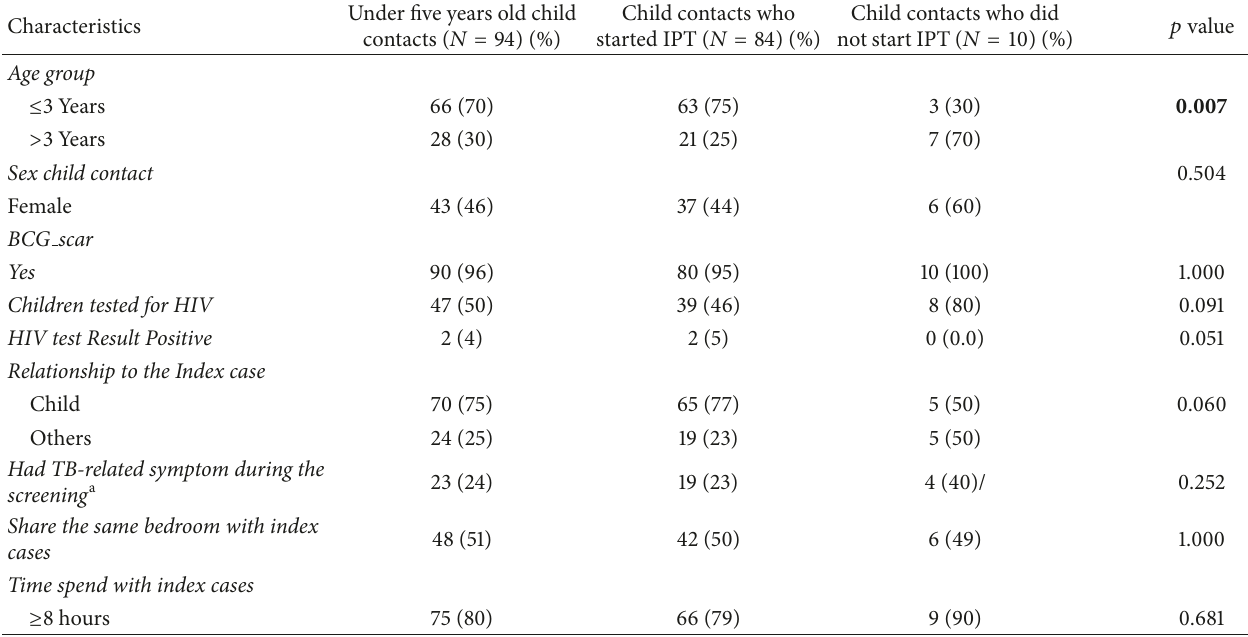
Table 3: Characteristics of child contacts eligible for IPT by IPT uptake.